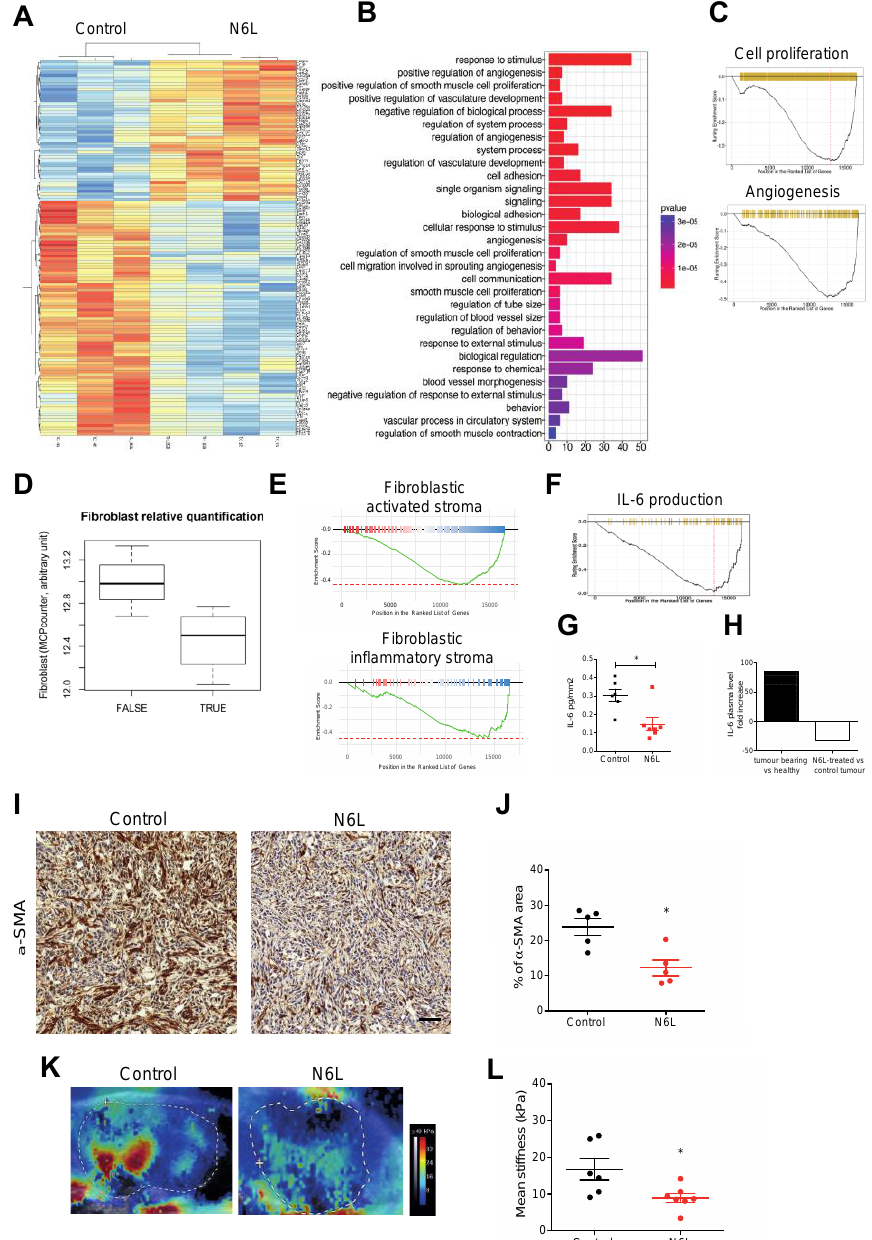
Figure 4. N6L regulates tumour stroma compartment. Tumours from mPDAC mice were harvested, and mRNAs were analysed by RNAseq. Data were normalized using the DESeq method. The